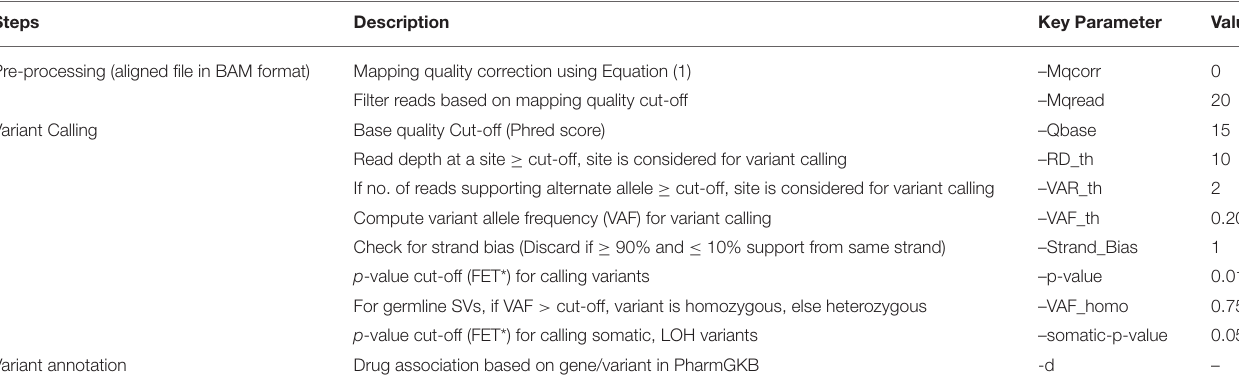
TABLE 2 | Various steps and corresponding parameters in the detection of SNVs and INDELs in SeqVItA are